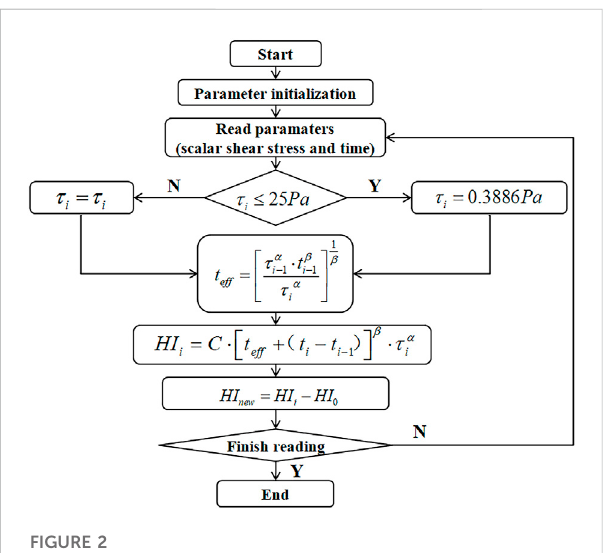
FIGURE 2 Novel model hemolysis prognosis process.